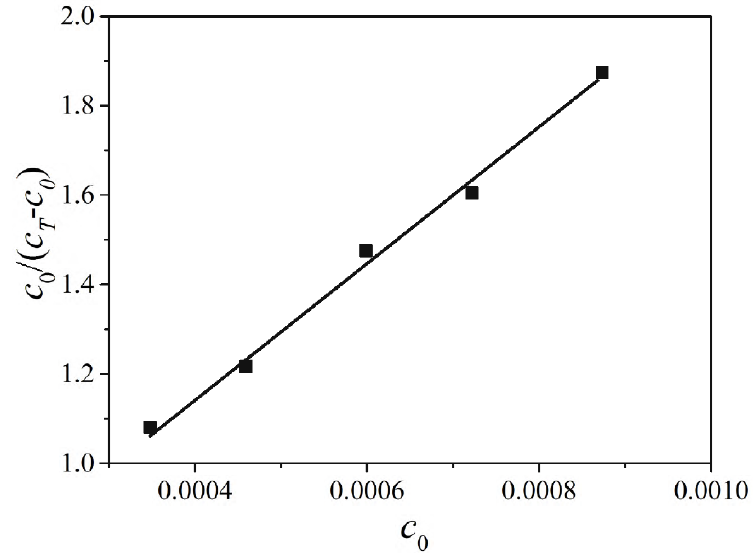
Figure 5. Linear relationship between c 0 / ( c T − c 0 ) and c 0 (solid points: experimental results; solid line(curve): fitted results). Table 3. Concentration of benzene before and after adsorption equilibrium at 25 °C. Total Concentration Filled into the Reactor c t